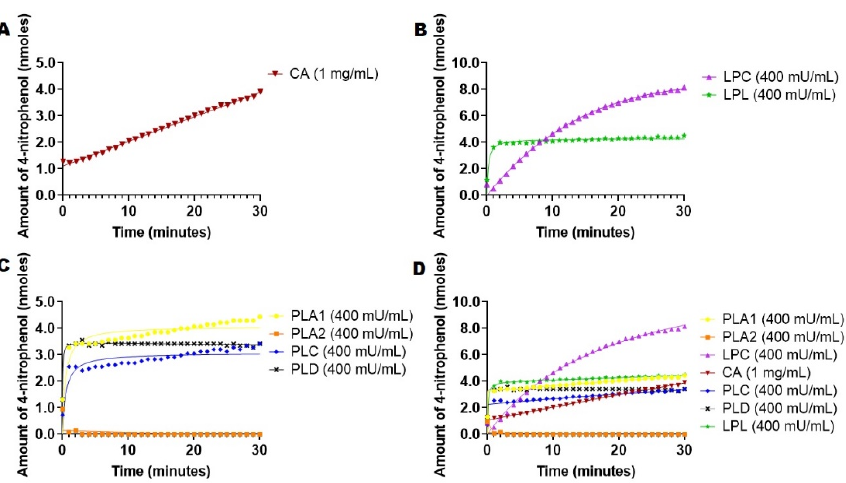
Figure 2. Hydrolysis of 4-nitrophenol palmitate catalyzed by different esterases present in the circulatory system at 400 mU/mL except CA (1 mg/mL). Enzyme kinetics were recorded via absorbance at 400 nm. The uncatalyzed hydrolysis of 4-nitrophenyl palmitate was deducted from the rate of catalyzed reaction observed. The amount of 4-nitrophenol released was determined against a calibration curve (Supplementary Materials, Figures S3 and S4). ( A ) Hydrolysis with CA. ( B ) Hydrolysis with lipases (LPC and LPL). ( C ) Hydrolysis with Phospholipases (A1, A2, C and D). ( D ) Hydrolysis with all esterases and lipases combined.